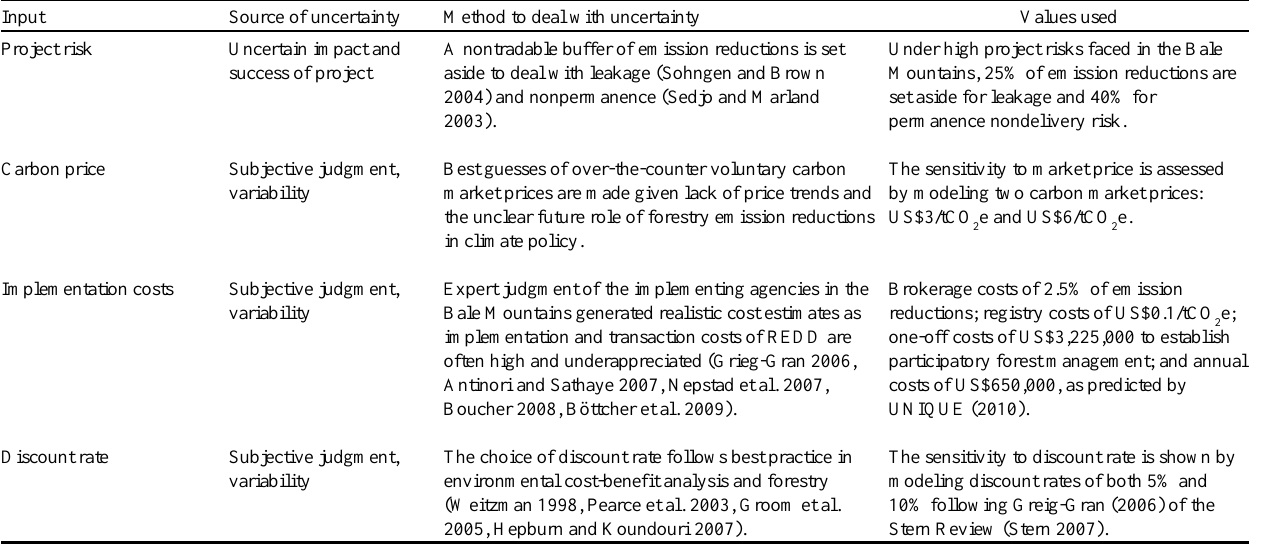
Table 2 . Inputs and sources of uncertainty in profit assessment and methods by which uncertainty is dealt with in this study.